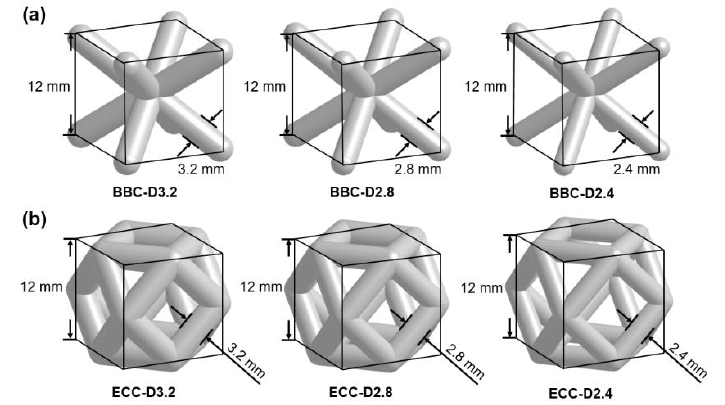
Figure 1. Geometry definition for two individual strut-based unit cells: ( a ) body-centered cubic (BCC) unit cell, and ( b ) edge-centered cubic (ECC) unit cell.